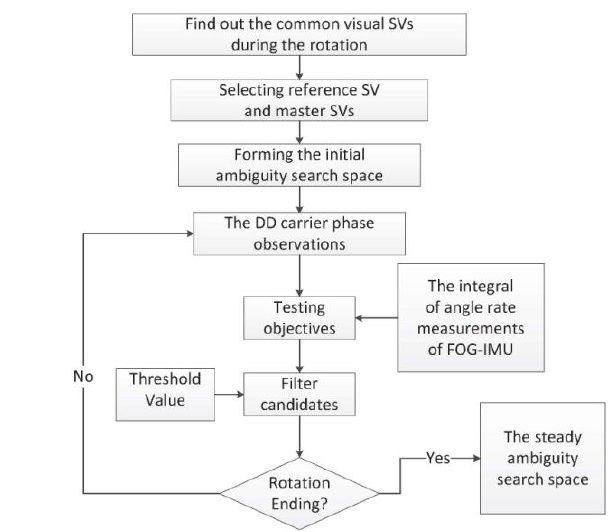
Figure 7. Scheme for actual field data